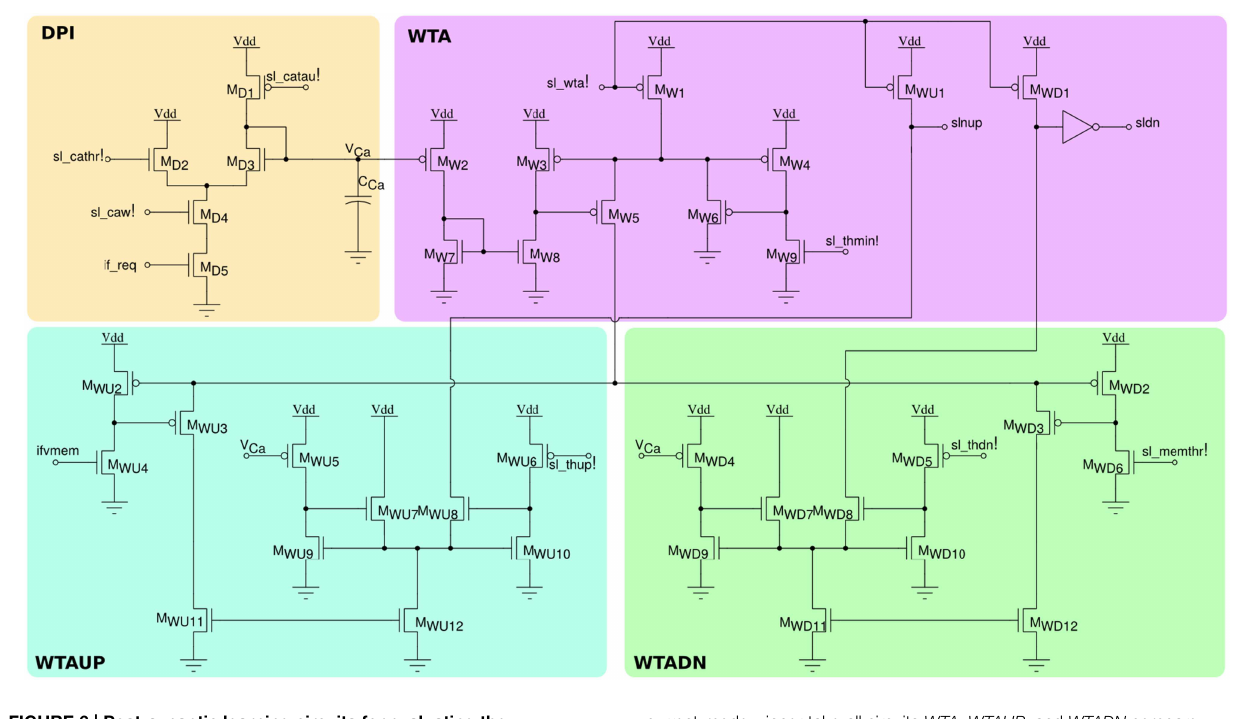
current-mode winner-take-all circuits WTA , WTAUP , and WTADN compare the Calcium concentration current to three set thresholds sl_thmin! , sl_thdn! , and sl_thup! , while the neuron’s membrane current is compared to the threshold sl_memthr! .